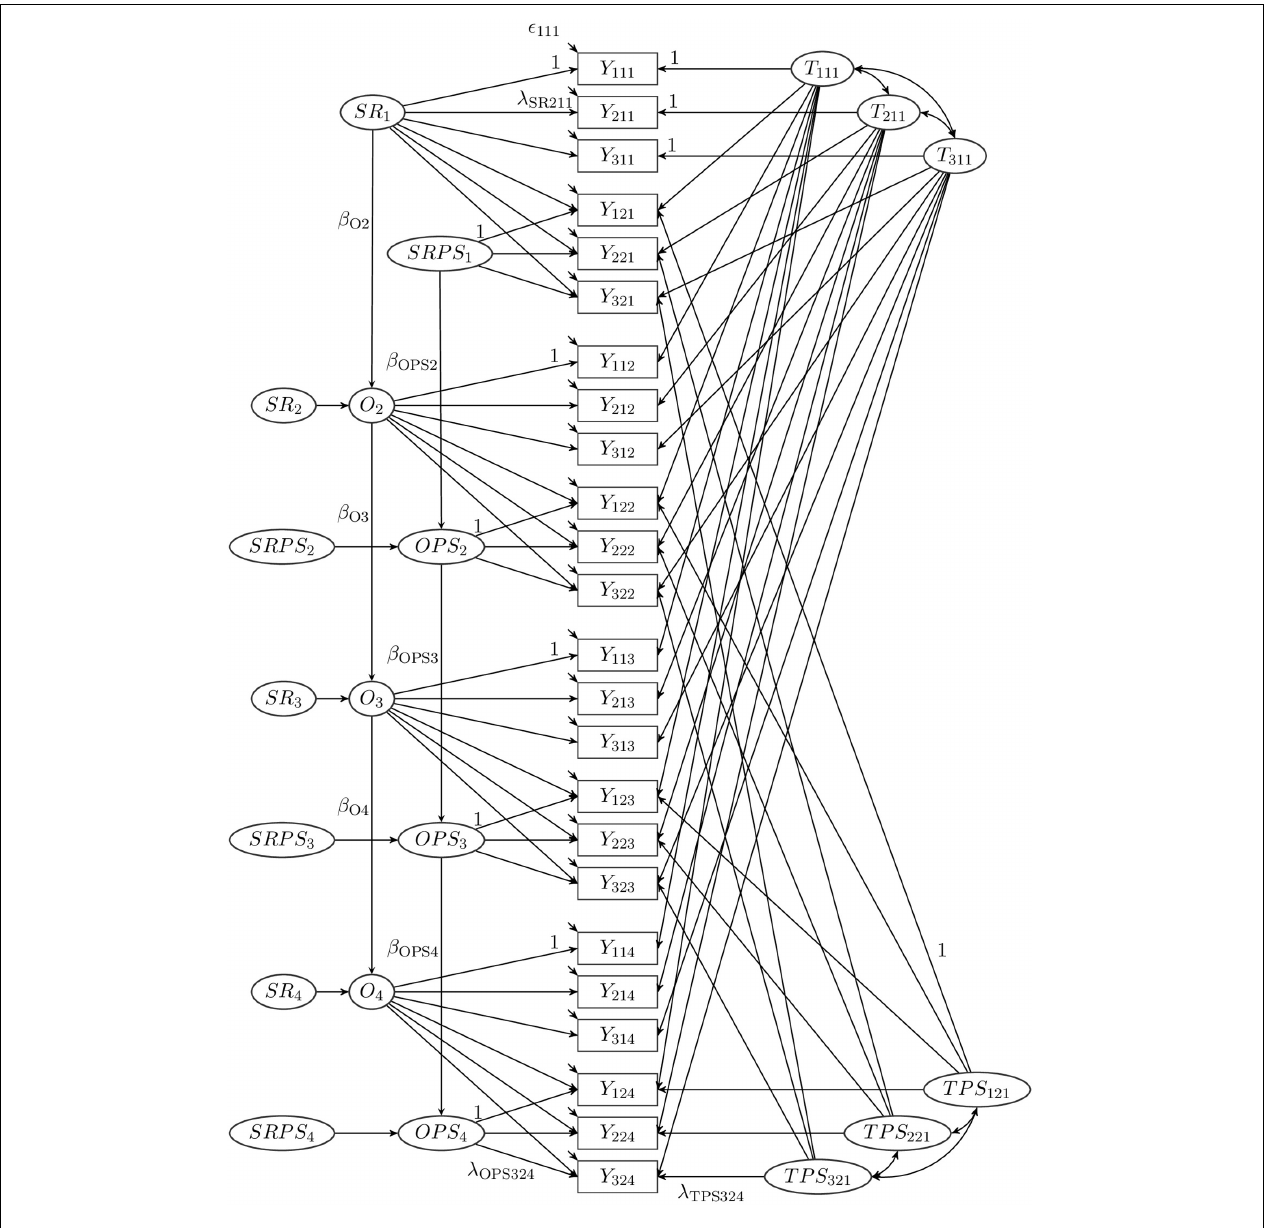
FIGURE 2 | Multi-rater latent state-trait model with autoregressive